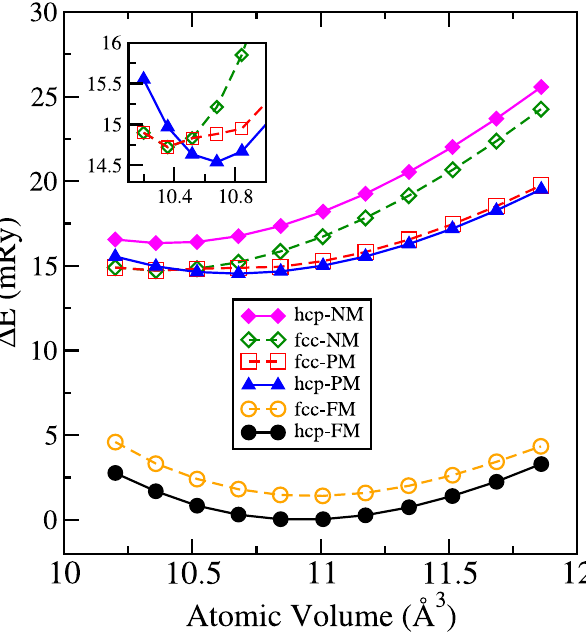
Figure 1. Calculated total energies for Co in the hcp and fcc phases in three magnetic states; FM (full- and open-circles, respectively), NM (full- and open diamonds, respectively) and PM (full-triangles and open- squares, respectively). Energies are given with respect to the energy of the FM hcp structure at the equilibrium volume. The inset shows a zoom-in for the fcc-NM, fcc-PM and hcp-PM curves near their